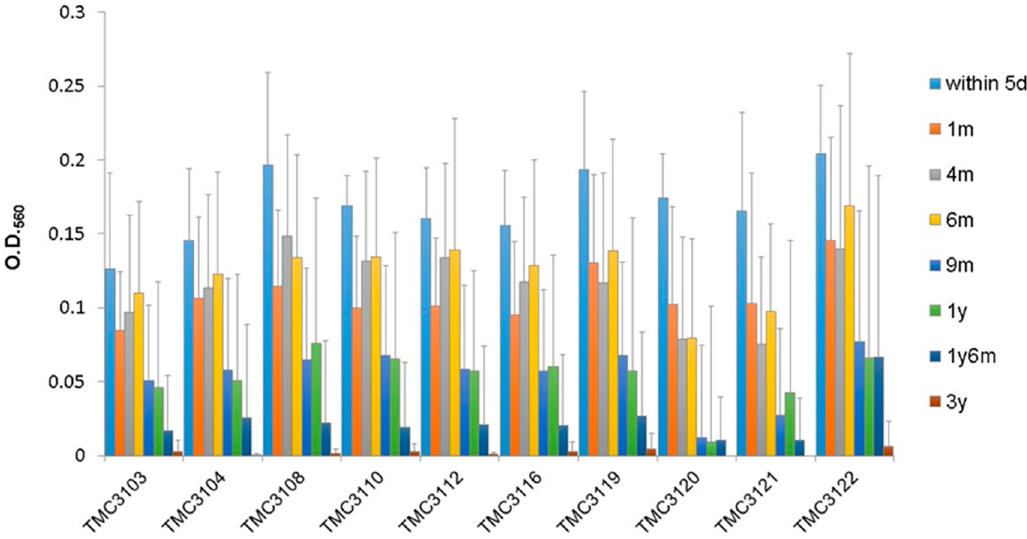
Figure 4. Adherence of ten additional strains of Bifidobacterium bifidum to human intestinal mucus.